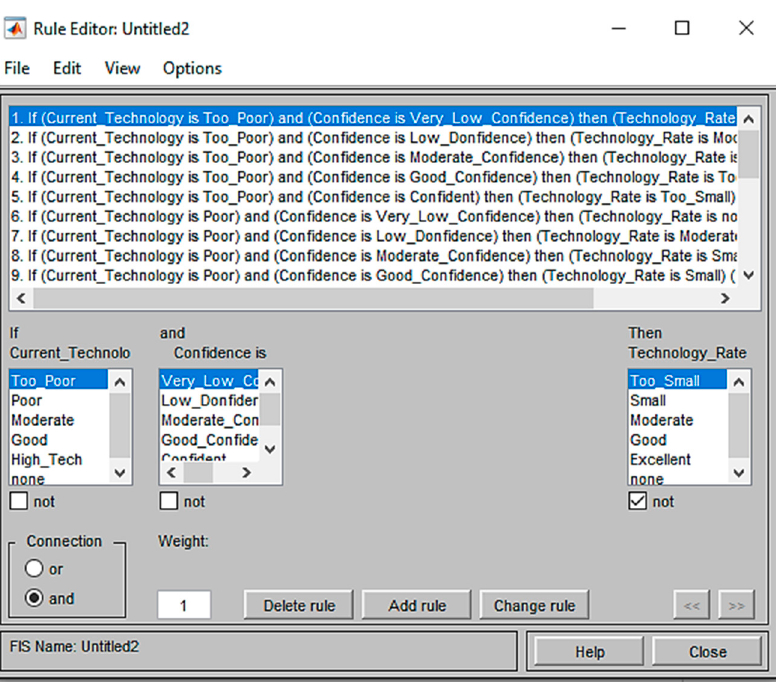
Figure 13. Fuzzy rules for the “current technology” and “confidence” in the proposed method.